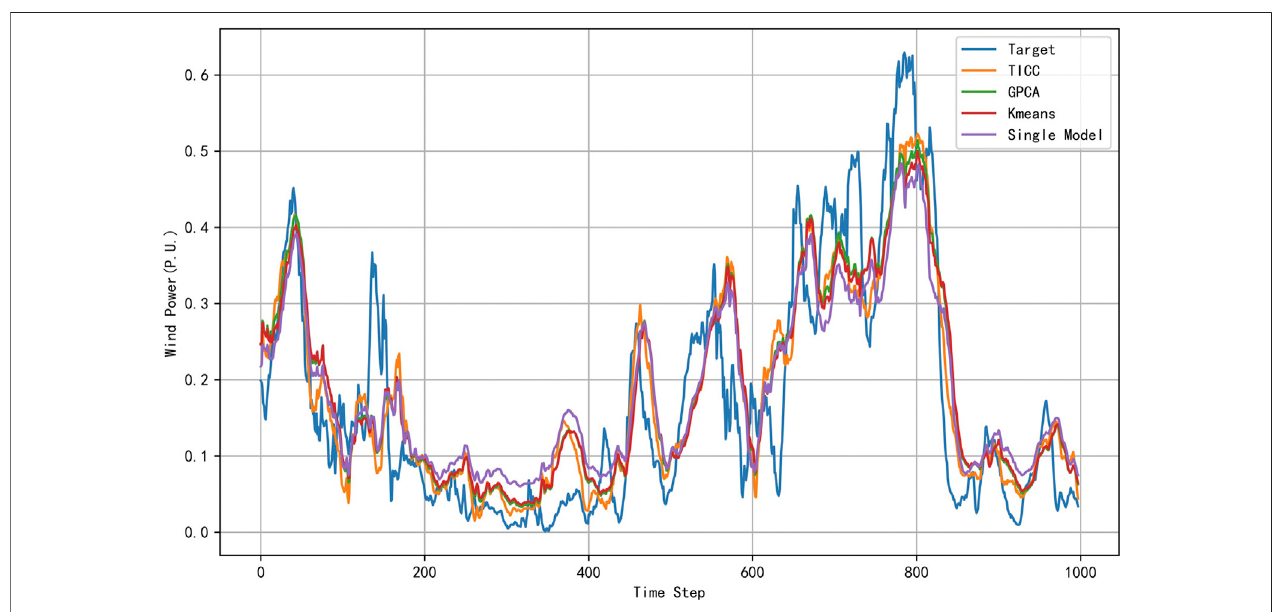
FIGURE 10 | The comparison of different regime division